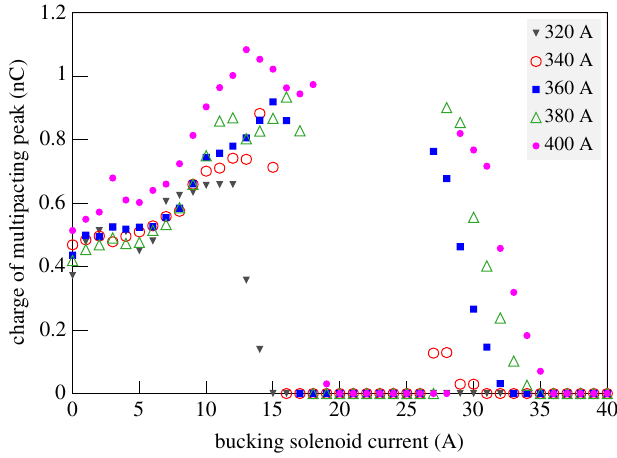
FIG. 13. (Color) Measured charge in the rear multipacting spike as a function of the bucking solenoid current for several main solenoid currents.